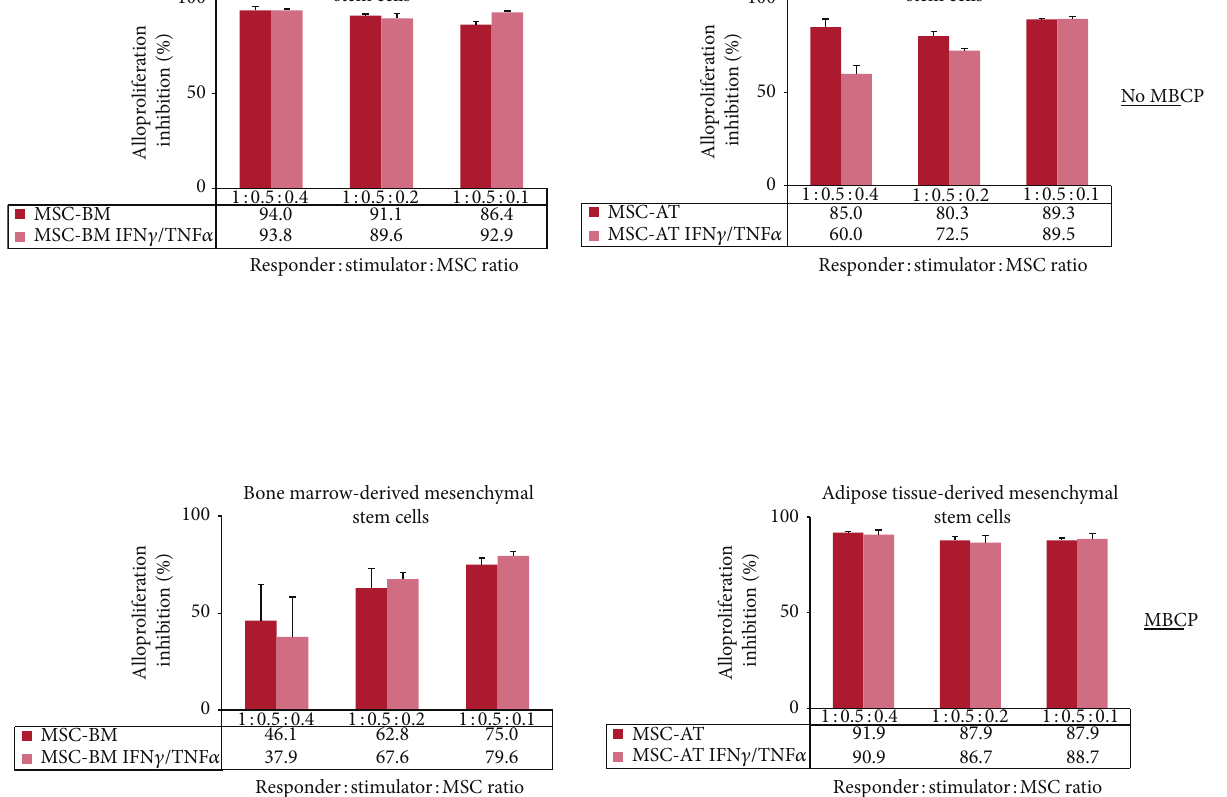
Figure 7: Both BM- andAT-derived MSCs when combined to MBCP biomaterial keep their immunosuppressive properties. PBMC from healthy individuals were used as responder cells towards irradiated LCL ∗ used as stimulating cells in presence of either BM-derived MSCs (MSC-BM) or AT-derived MSCs (MSC-AT) that were pretreated with IFN 𝛾 and TNF 𝛼 (IFN 𝛾 /TNF 𝛼 ) or not and used as third-party cells at various responder: stimulator:MSC ratios. MSCs were combined to MBCP biomaterial (MBCP) or not (No MBCP). Results are given as mean percentage of alloproliferation inhibition ± s.e.m. when compared to PBMC+LCL ∗ using PBMC from 3 distinct healthy donors.